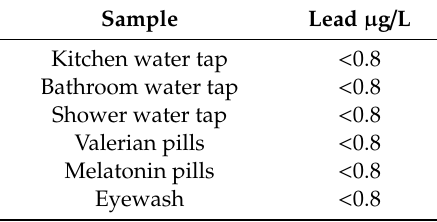
Table 3. Lead content in herbal medicines (valerian and melatonin), tap water (kitchen and bathroom) and eyewash.